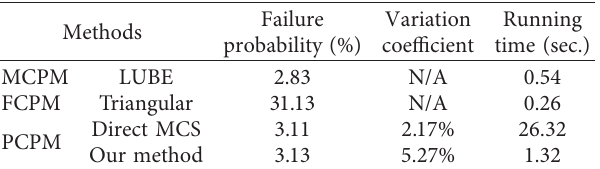
Table 3: Schedule network failure evaluation comparison (dead- line � 690